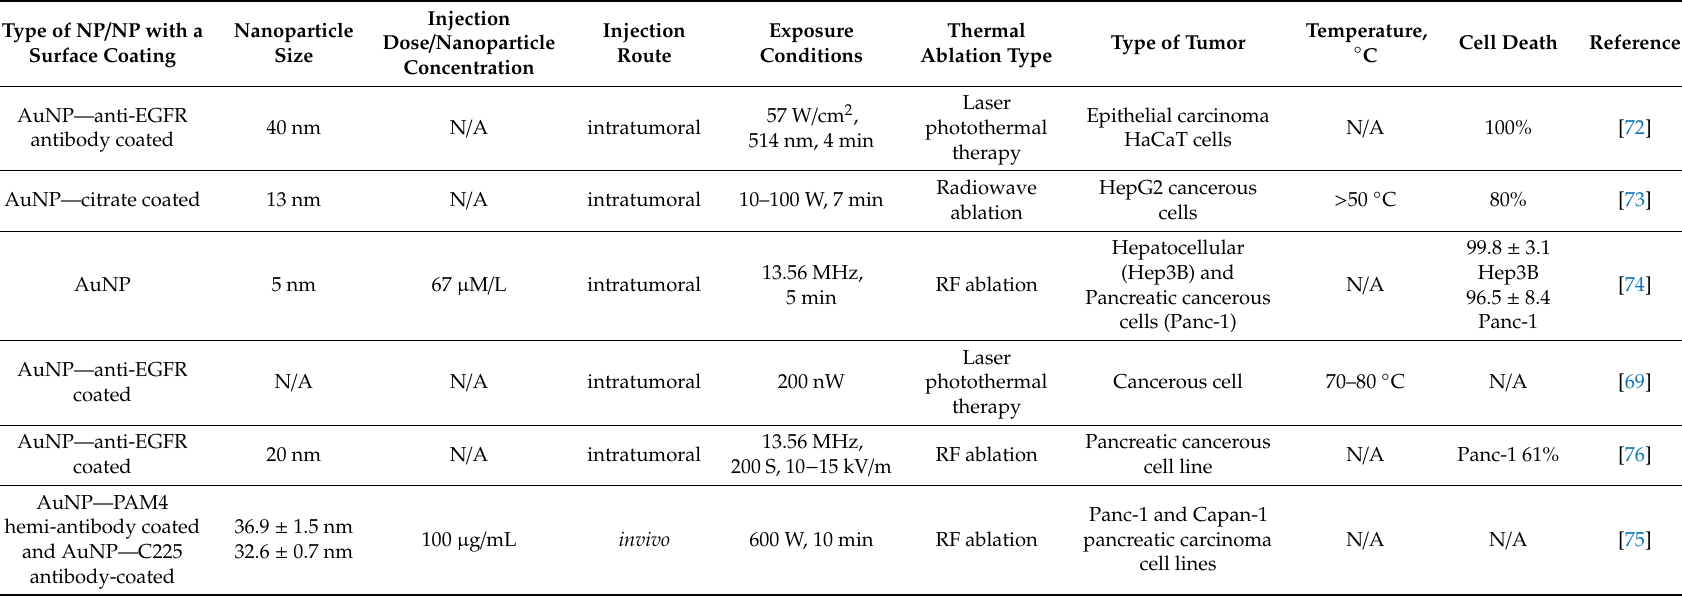
Table 2. Summary of AuNPs application in the thermal ablation of cancer (GFR: epidermal growth factor